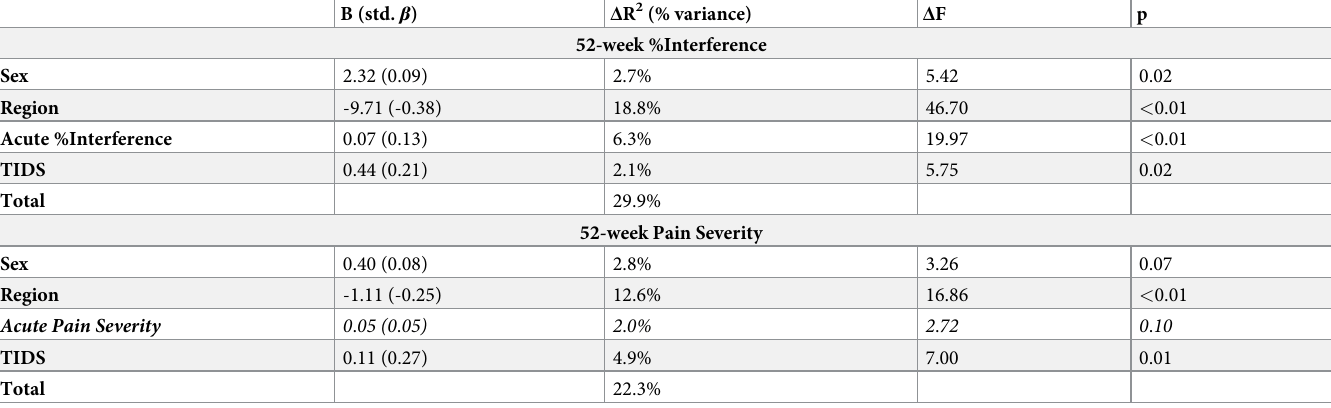
Table 2. Results of stepwise linear regression for 52-week % Interference and 52-week Pain Severity. Β (std. β )